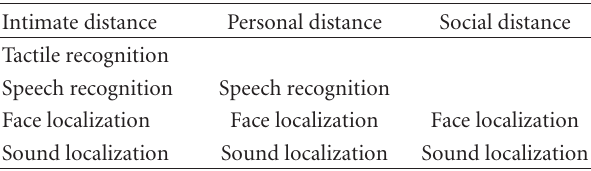
Table 1: Relationship between distance and function. Intimate distance